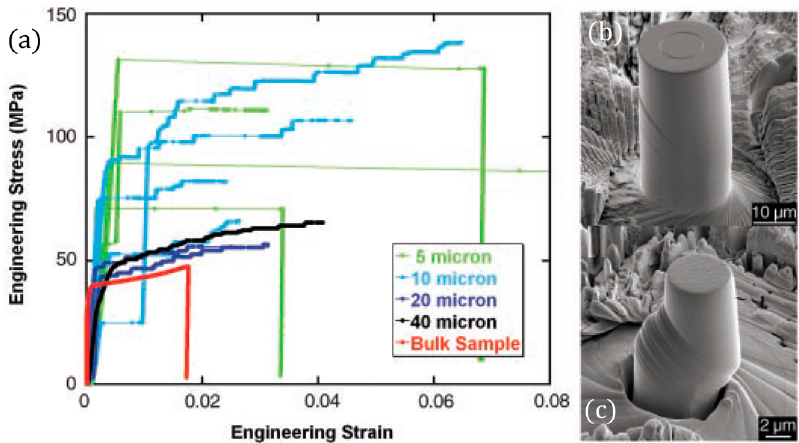
Figure 12. Response of pure Ni pillars during the uniaxial compression experiment at room temperature. ( a ) Stress-strain curves for pillars with diameters that vary from 40 to 5 μm and a bulk single crystal having approximate dimensions of 2.6 × 2.6 × 7.4 mm. ( b ) A scanning electron micrograph (SEM) image of a pillar with the diameter of 20 μm at 4% strain. ( c ) A SEM image of 5 μm diameter pillar at 19% strain during a rapid burst of deformation (after Uchic et al. [111]).